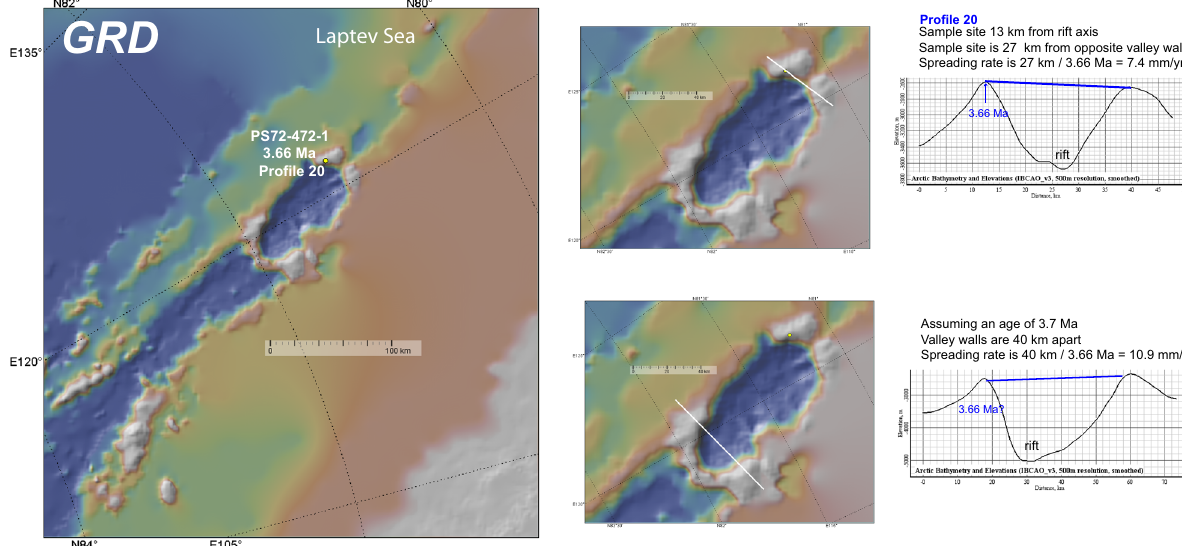
Fig. 5 Age-distance pro fi le in the GRD. P20 predicts the dismemberment of a 3.7 Ma 10 axial volcano. Note that the wider rift valley to the west of P20 corresponds broadly with the width of the EVZ whereas the narrower rift valley east of P20 extends into the Laptev Sea. Furthermore, assuming that the volcanism on the fl ank of the wider axial valley at the western end of the GRD is also 3.7 Ma yields a faster EVZ-like spreading rate. Other details as in Fig.